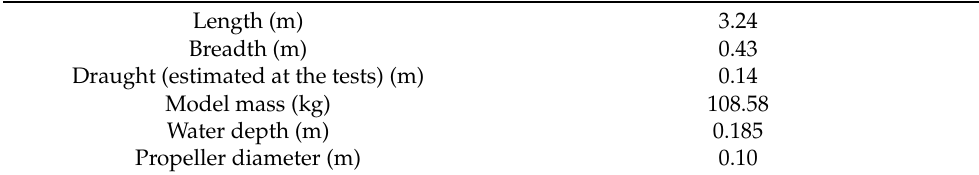
Figure 1. The free-running ship model during the manoeuvring tests. Table 1. Main dimensions of the container model. Table 1. Main dimensions of the container model.